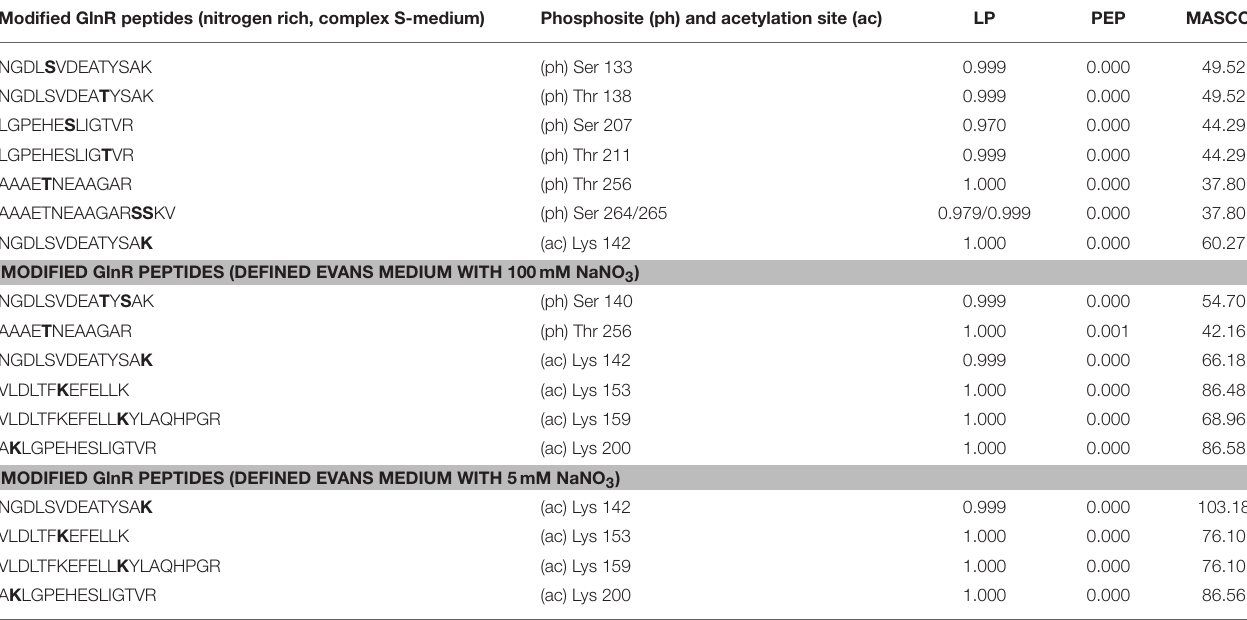
TABLE 3 | Phosphorylated and acetylated GlnR peptides detected by LC-MS/MS under complex and defined N- conditions. Modified GlnR peptides (nitrogen rich, complex S-medium) Phosphosite (ph) and acetylation site (ac) LP PEP